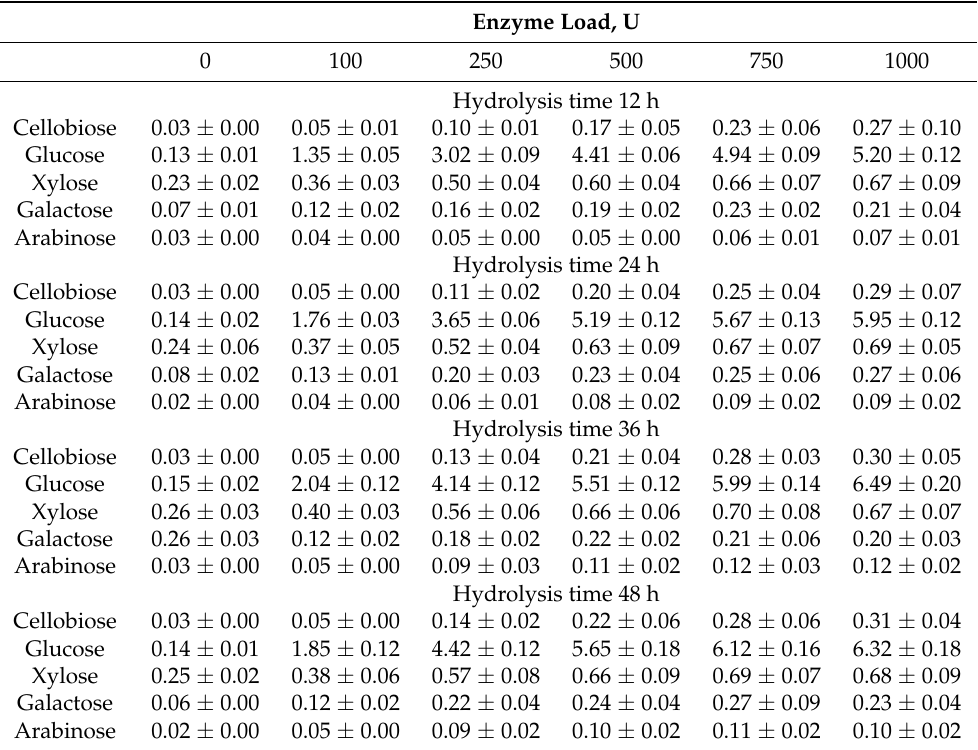
Table 3. Dominant carbohydrate contents (g per 15 g of substrate (LC residue sample treated with an H 3 PO 4 /NaH 2 PO 4 catalyst mixture at a ratio of 1:1)) in enzymatic hydrolysis liquid products depending on enzyme load and hydrolysis